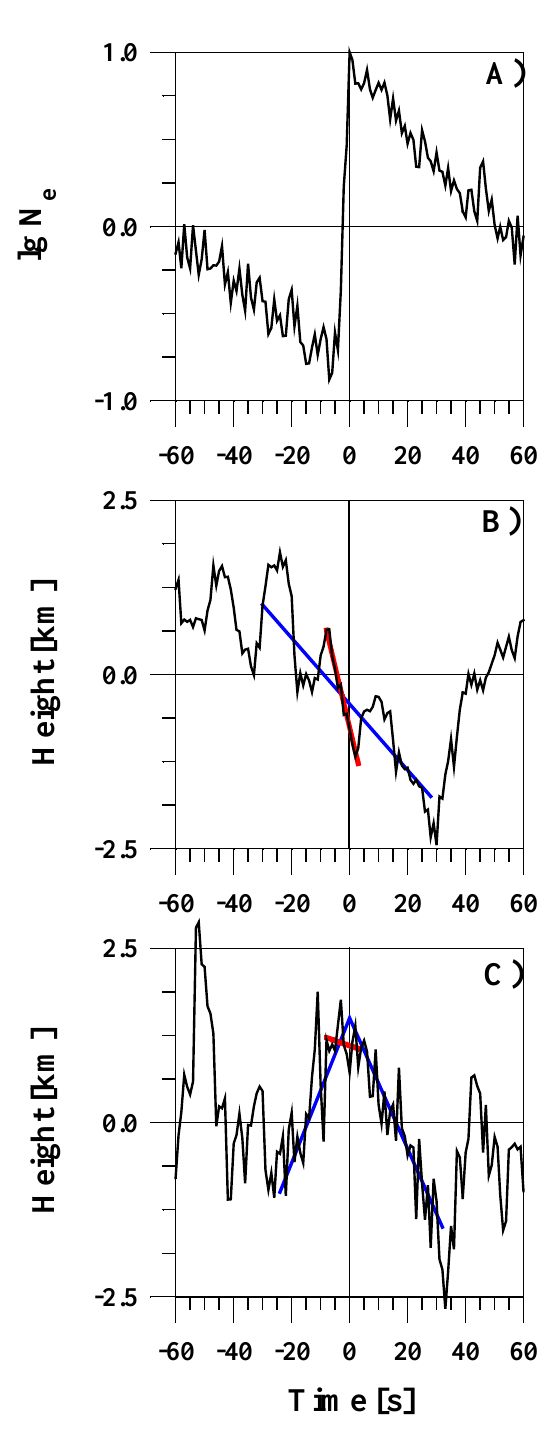
Fig. 10. (A) Change in the ionospheric electron density observed by the EISCAT radar during pulsed electron precipitations. (B) and (C) Change in the height of the ionospheric density maximum in the pulses observed in the beginning (B) and at the end (C) of the